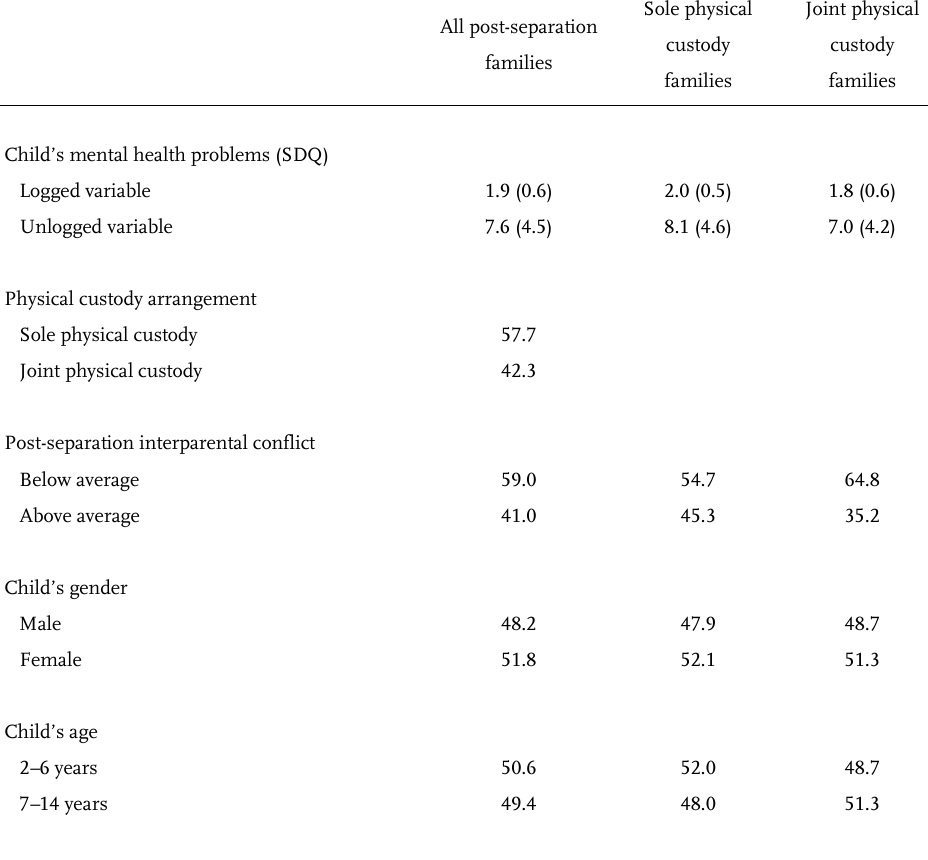
Table 1 : Descriptive sample statistics: Percentages or means (standard deviations)